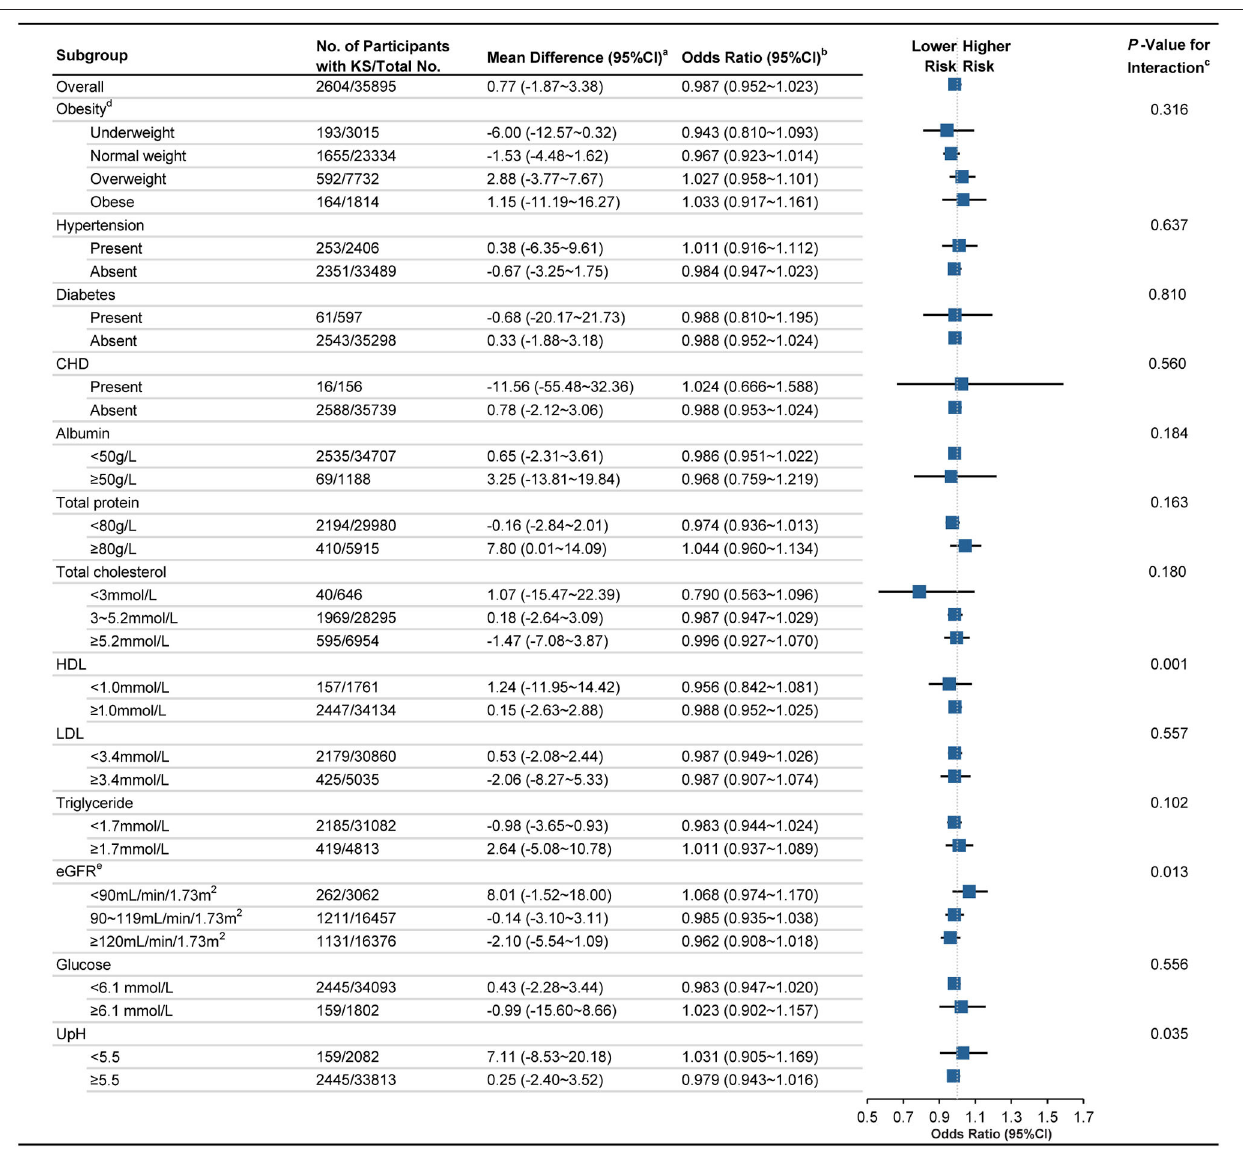
FIGURE 3 | Association between UA level and KS in female population among different subgroups. KS, kidney stone; CI , confidence interval; CHD coronary heart disease; HDL, high-density lipoprotein cholesterol; LDL, low-density lipoprotein cholesterol; eGFR, estimated glomerular filtration rate; UpH, Urine pH. a Calculated applying bootstrap method. Details can be found in Methods-Statistical analyses Section. b Calculated applying model 3 (as shown in Methods-Statistical Analyses Section for descriptions of model 3) and taking per 50 µ mol/L UA as a unit. c Calculated by applying Wald test. d Classified according to the recommendation defined by Working Group on Obesity in China. e Calculated using the CKD–EPI equation. Details can be found in Methods